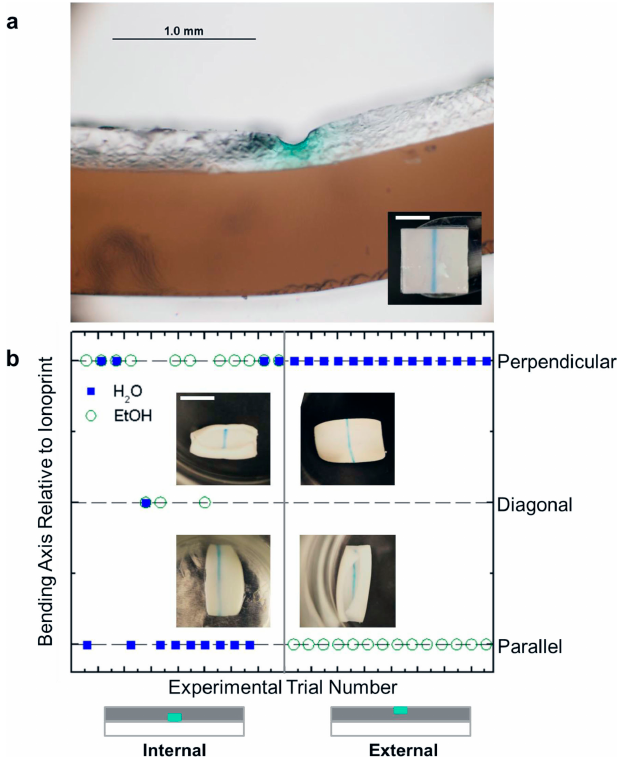
Figure 4. Ionoprinted multi-responsive bilayer actuators. ( a ) Micrograph of the cross-section of the bilayer with an external ionoprint. Inset: Top down view of an ionoprinted bilayer. Scale bar = 12 mm. ( b ) The final orientation of the bending axis relative to the ionoprint direction at 40 °C as a function of experimental trial number. Left column: Gel bilayers with the internal ionoprints located at the interface. Right column: Gel bilayers with the external ionoprints located away from the interface. Insets: Photographs of the bilayer bending behavior. Scale bar = 12